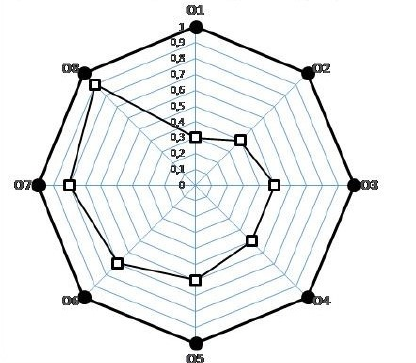
Figure 1. Radar chart for vector x = (0 . 3 , 0 . 4 , 0 . 5 , 0 . 5 , 0 . 6 , 0 . 7 , 0 . 8 , 0 . 9). Painted circles are the tops of a regular octagon, open squares are the coordinates of the x vector. Source: own